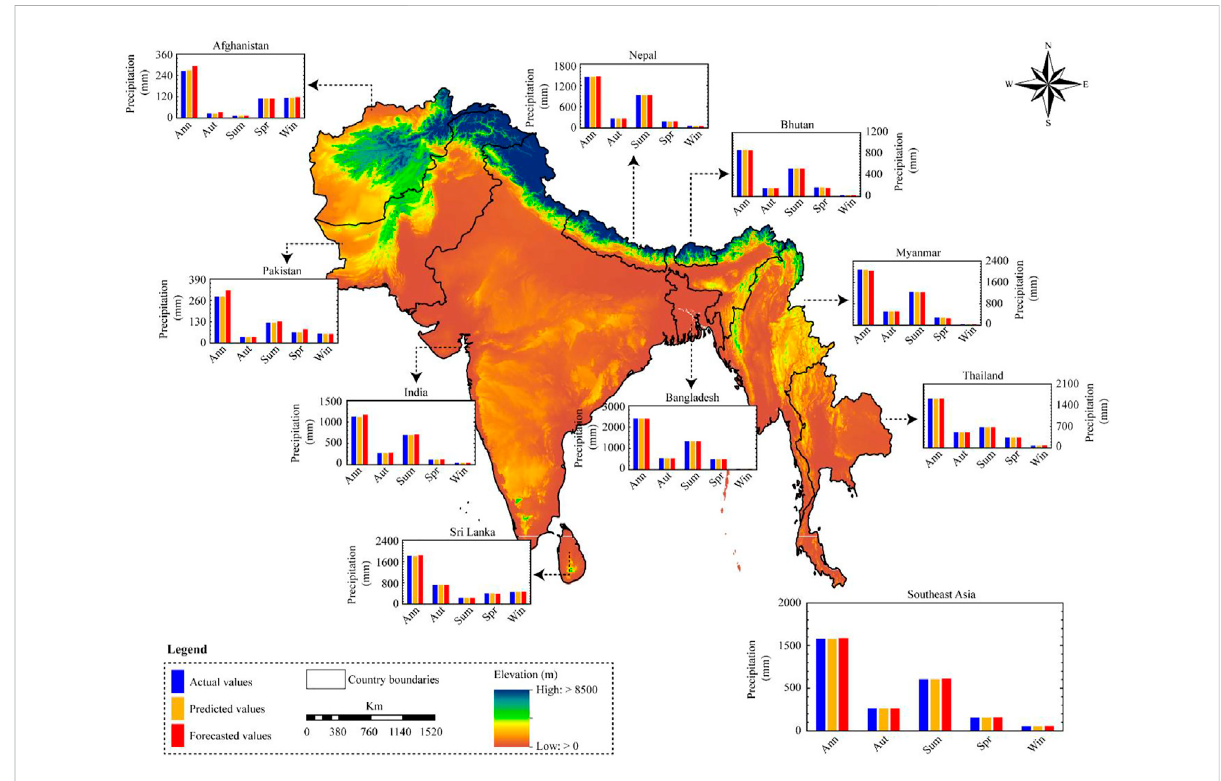
FIGURE 2 Comparison of ARIMA model results for country wise forecasting as well as for the whole